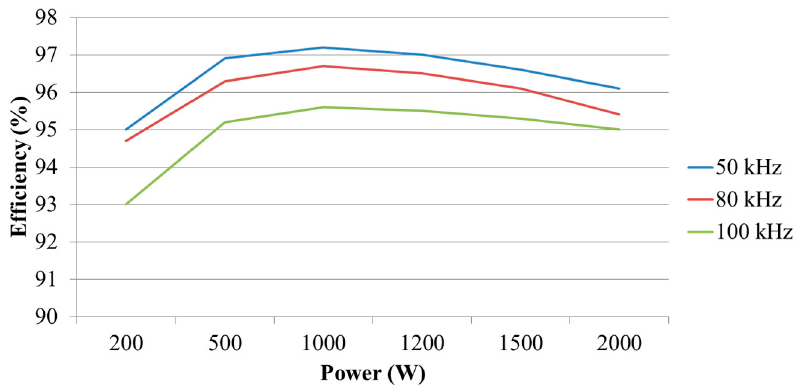
Figure 26. E ffi ciencies of GaN-based shunt APF system at di ff erent switching frequencies. Figure 26. Efficiencies of GaN-based shunt APF system at different switching frequencies.